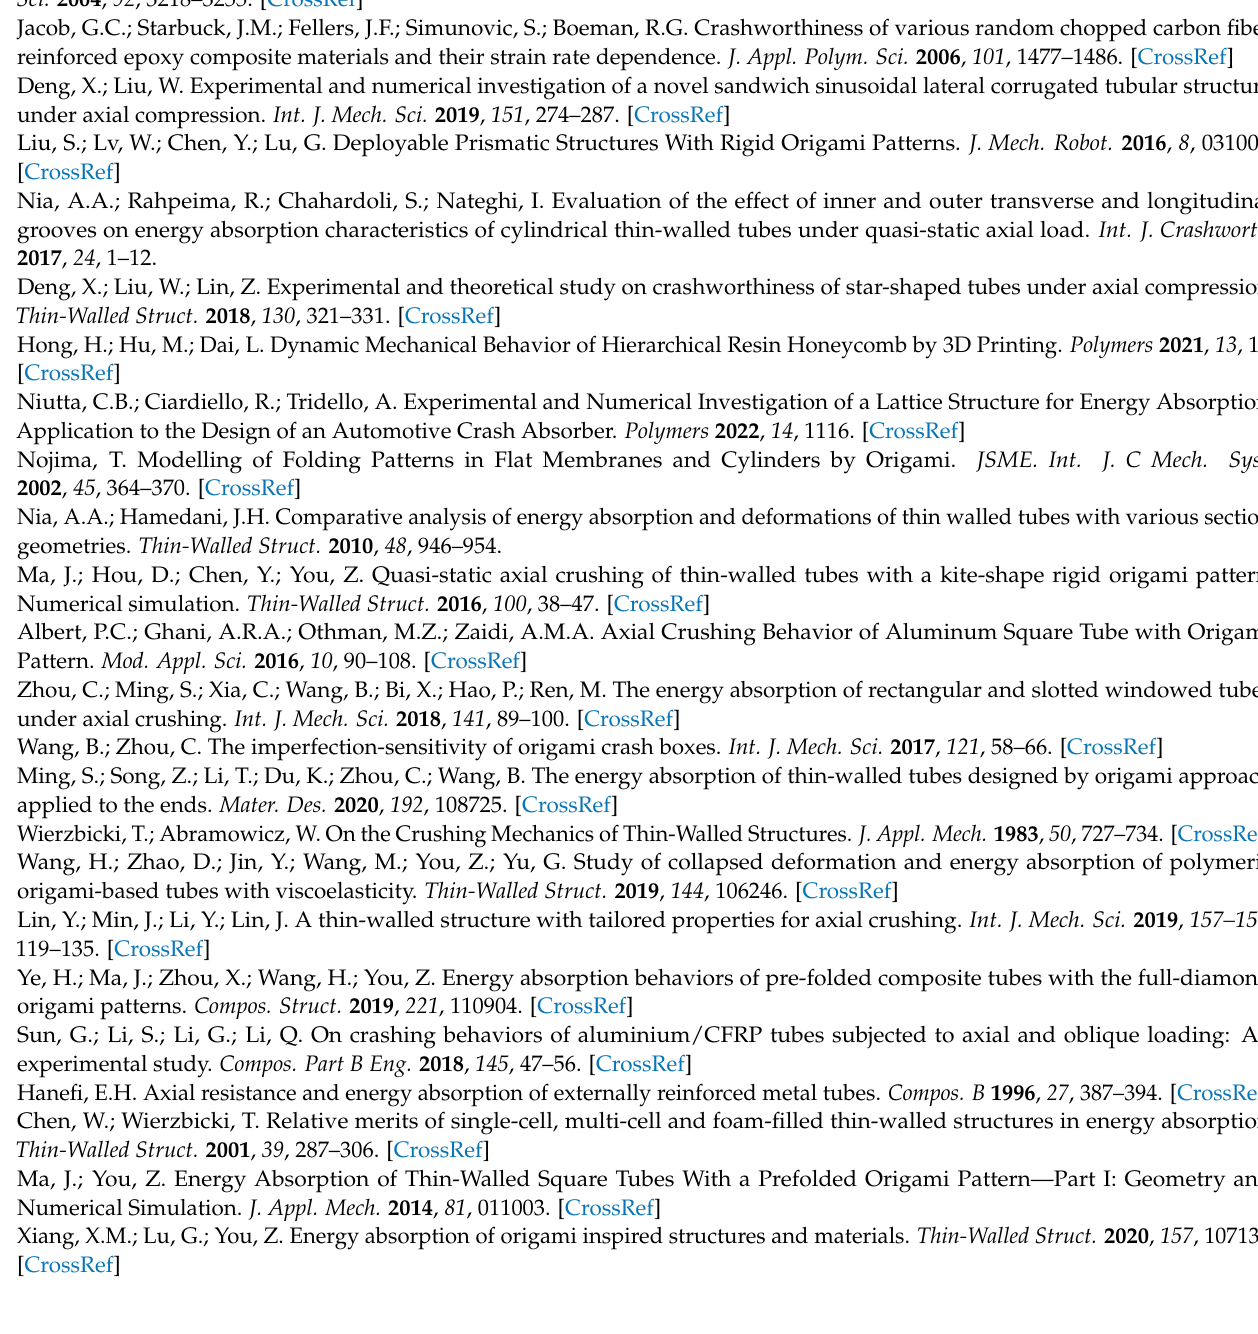
Figure A4. ( a ) Plastic hinge line before moving; ( b ) plastic hinge line after moving.